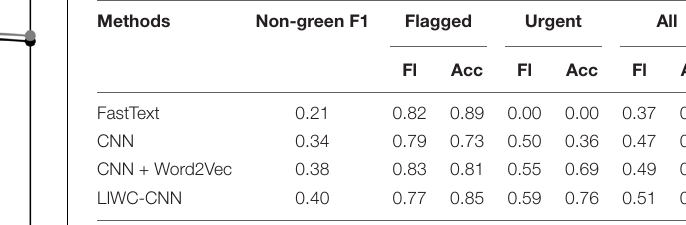
TABLE 3 | Comparison of experimental results of various